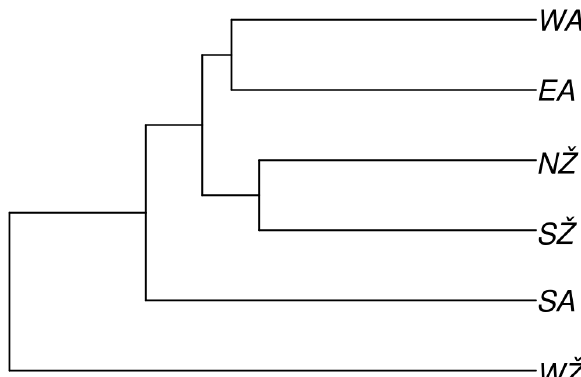
Figure 5. An UPGMA phylogenetic tree shows the time of the divergence between the ethnolinguistic regions of Lithuania. EA—Eastern Aukštaitija, SA—Southern Aukštaitija, WA—Western Aukštaitija, NŽ—Northern Žemaitija, SŽ—Southern Žemaitija, WŽ—Western Žemaitija.